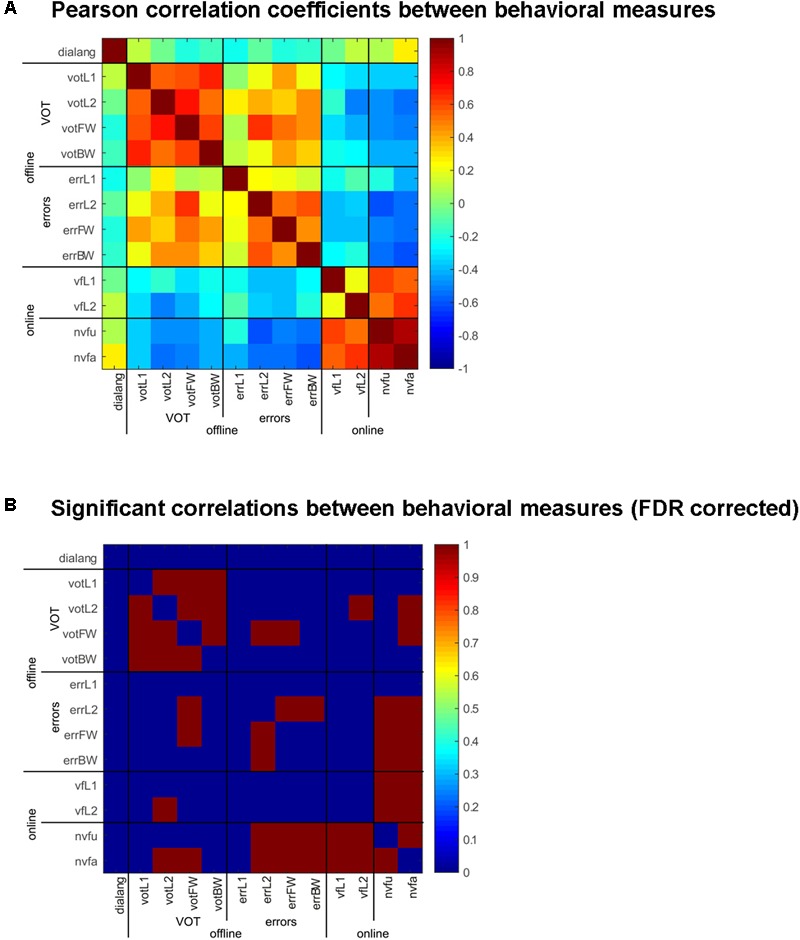
Correlation of behavioral measures in the online and offline tasks and the DIALANG measures. (A) Pearson correlation coefficients between the behavioral measures (VOT and errors) in the offline tasks (naming in L1 and L2 and forward and backward translation) and the online tasks [verbal fluency in L1 and L2 and non-verbal fluency (unique and all designs)] comparing sham vs. anodal-tDCS stimulation. Warm colors indicate positive correlations, cold colors indicate negative correlations. (B) Significant [FDR-corrected (adjusted p-value: p = 0.011)] correlations between the behavioral measures are indicated in red, and non-significant values in blue.